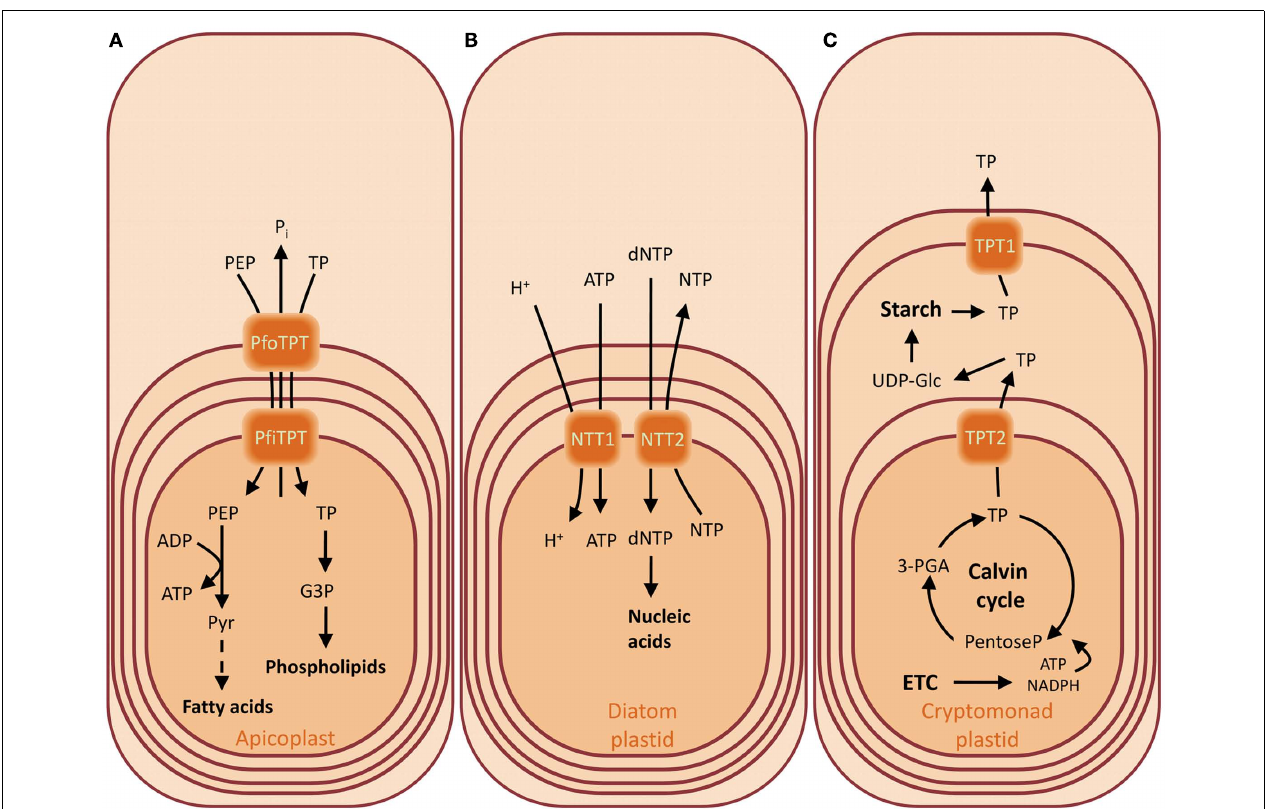
which catalyze a uniport mode of transport as in the chlamydial intracellular parasites from where these transporters were acquired (B) .The cryptomonads contain a less reduced secondary endosymbiont, still harboring a vestigial nucleus in the periplasmic compartment, the former algal cytoplasm, where the starch is synthesized.The day and night path of carbon metabolism are regulated by differential expression ofTPT genes whose products localize in different envelopes (C) . Abbreviations: (d)NTP, (deoxy)nucleotide triphosphate; G3P, glycerol 3-phosphate; PEP, phospho enol pyruvate; PfiTPT, P. falciparum innermost envelopeTPT; PfoTPT, P. falciparum outermost envelopeTPT; 3-PGA, 3-phosphoglycerate; Pi, inorganic phosphate;TP, triose phosphate; UDP-Glc,